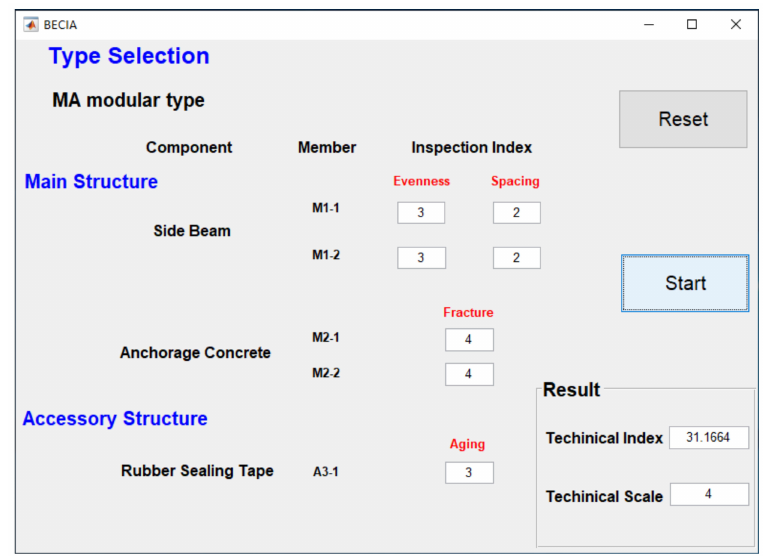
Figure 8. Operation interface of BECIA